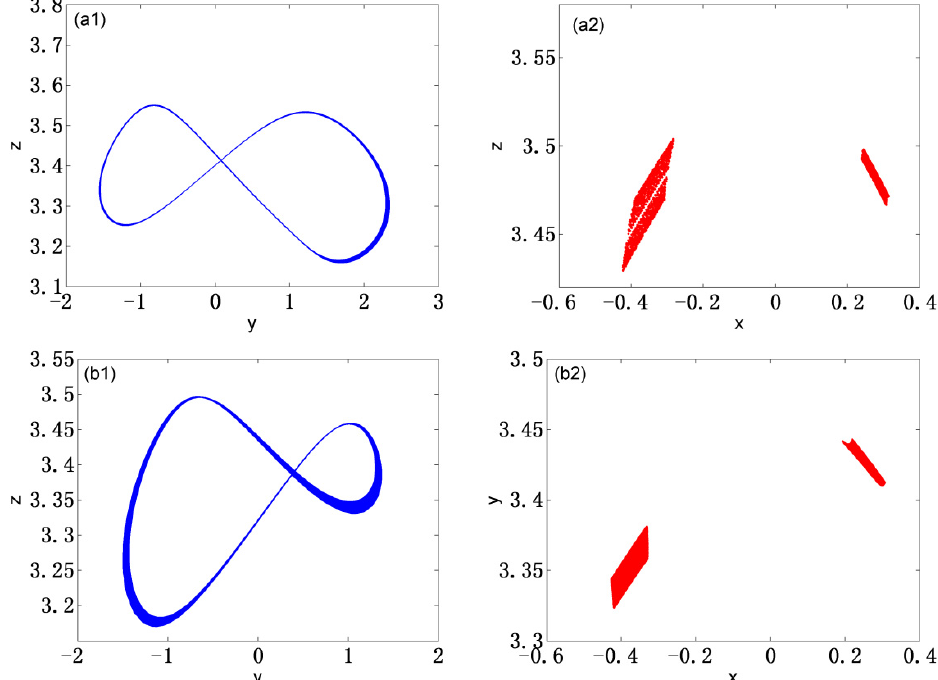
Figure 11. Coexistence of hidden chaotic attractors with symmetrical structure for different initial values. ( a1 , a2 ) are phase trajectory and Poincare maps with initial value (0, 2, 0, 0), respectively. ( b1 , b2 ) are phase trajectory and Poincare maps with initial value (1, − 2, 0, 1), respectively.